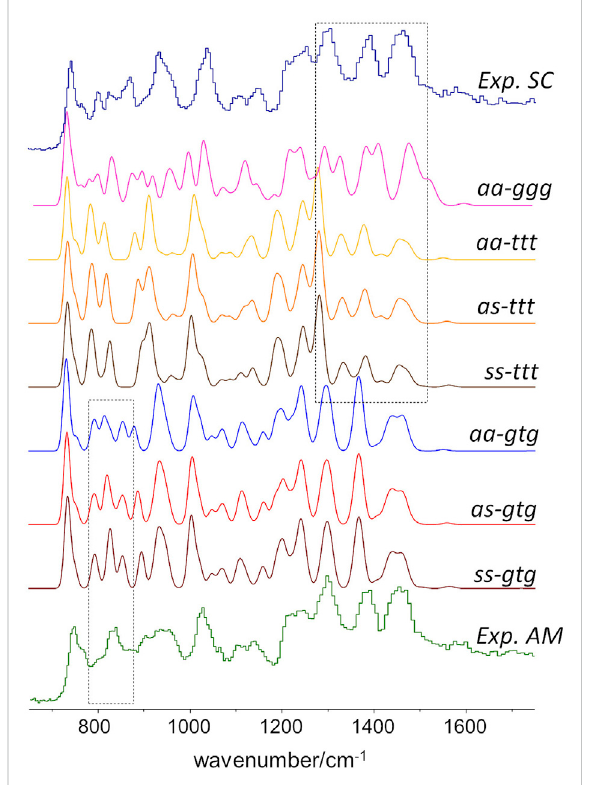
FIGURE 3 Comparison of the INS patterns in the 650 – 1750 cm − 1 region theoretically predicted for the seven triads shown in Figure.2, with the experimental INS patterns of PBF semi-crystalline (top trace) and amorphous (bottom trace) samples. The dashed rectangles highlight two regions of clear pattern de fi nition.